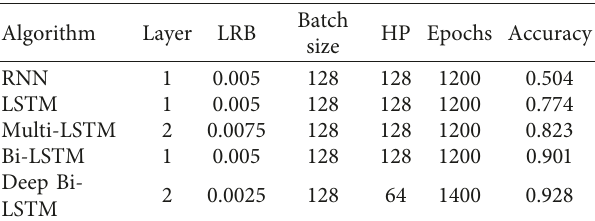
Figure 10: Performance of the model in the smartphone. Table 5: Performance of deep Bi-LSTM compared to other